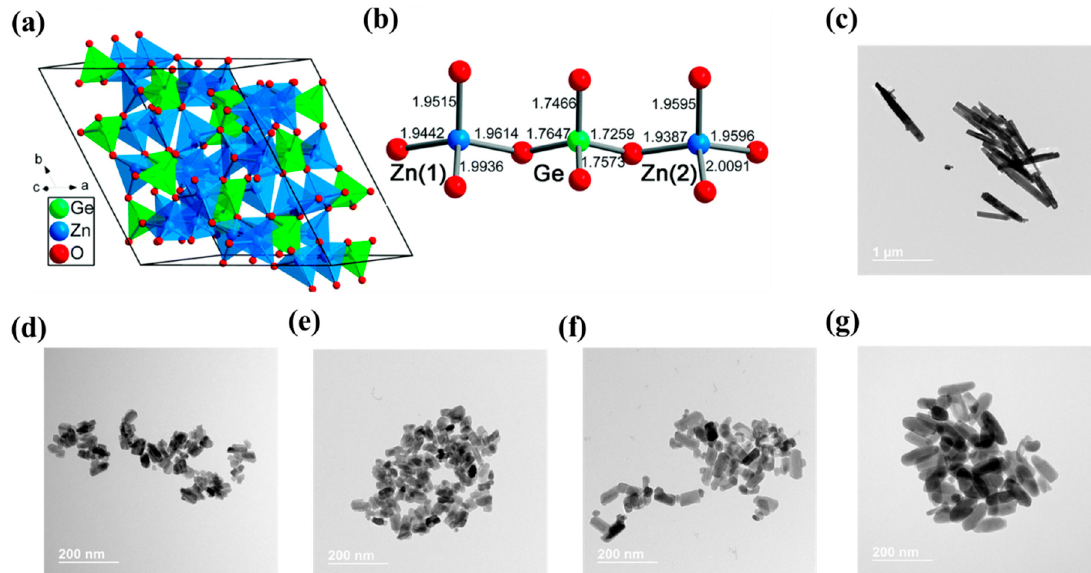
Figure 4. ( a ) Crystal structure of Zn 2 GeO 4 (blue tetrahedra: ZnO 4 ; green octahedra: GeO 4 ), ( b ) coordination environment of the Zn 2+ and Ge 4+ ions in this structure [92], TEM images of Zn 2 GeO 4 samples synthesized with different TEA volumes: ( c ) 0 mL, ( d ) 2 mL, ( e ) 4 mL, ( f ) 6 mL and ( g ) 8 mL [60]. (Reproduced from Refs. [60,92] with permission from the RSC).